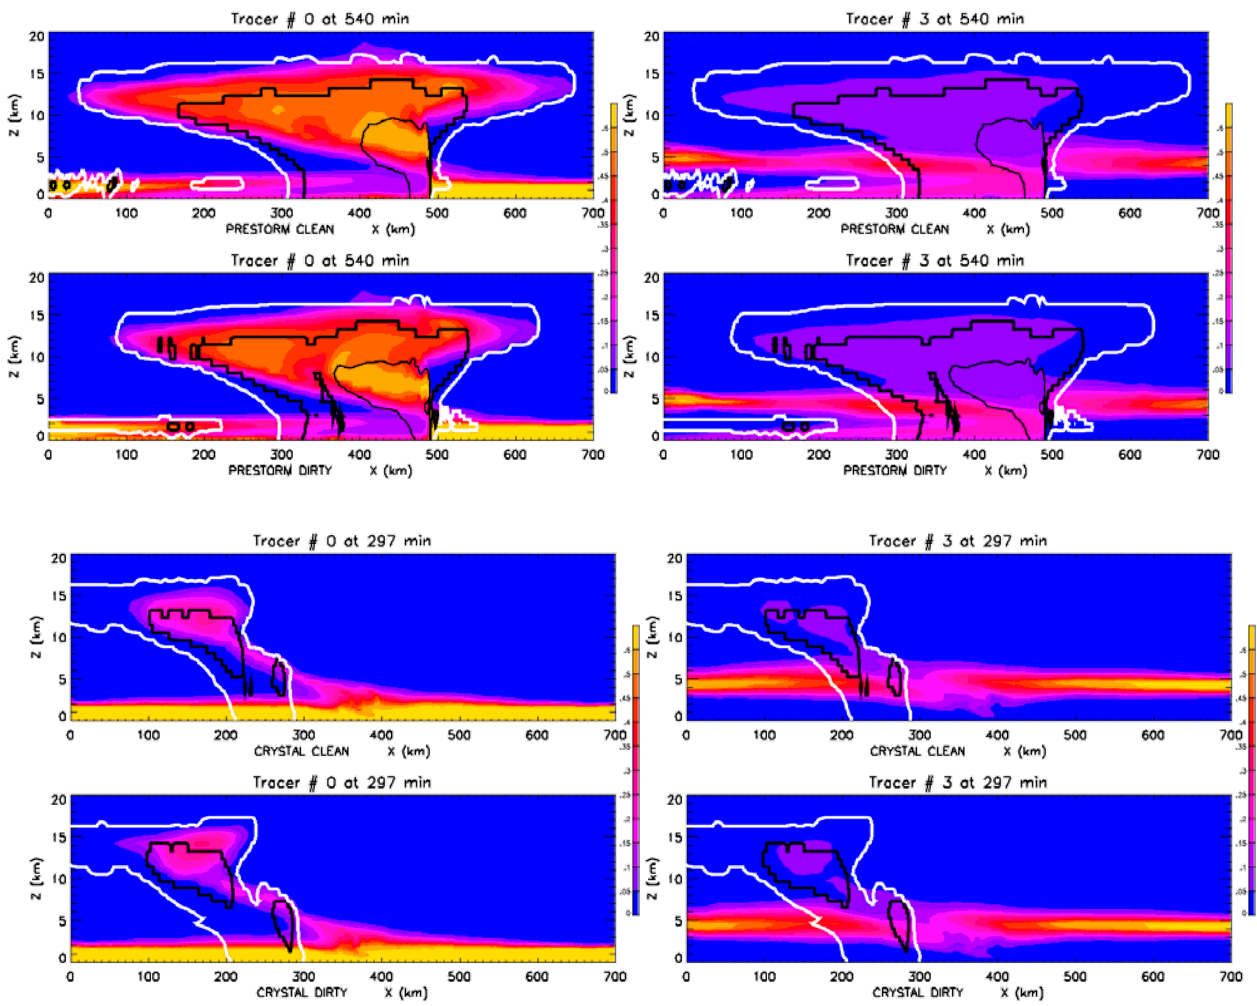
Fig. 3. Tracer analyses for a mid-latitude squall line (top four panels) and a Florida convective cloud (bottom four panels) for both clean and dirty environments. Tracers at low (from the surface to 1.5km, left four panels) and middle levels (from 3 to 4.5km, right four panels) were released to examine their respective contribution to the overlying free troposphere. The degree of vertical re-distribution is indicative of the intensity (and contribution for cloud development) of the convection and reflects the transport structure responsible for the mixing. The results show that more than 50% of the low-level tracer reaches the upper troposphere for the mid-latitude squall system compared to less than 10% for the midlevel tracer. For the Florida cloud, the low-level tracer also contributes more than 2.5 times that from mid levels.